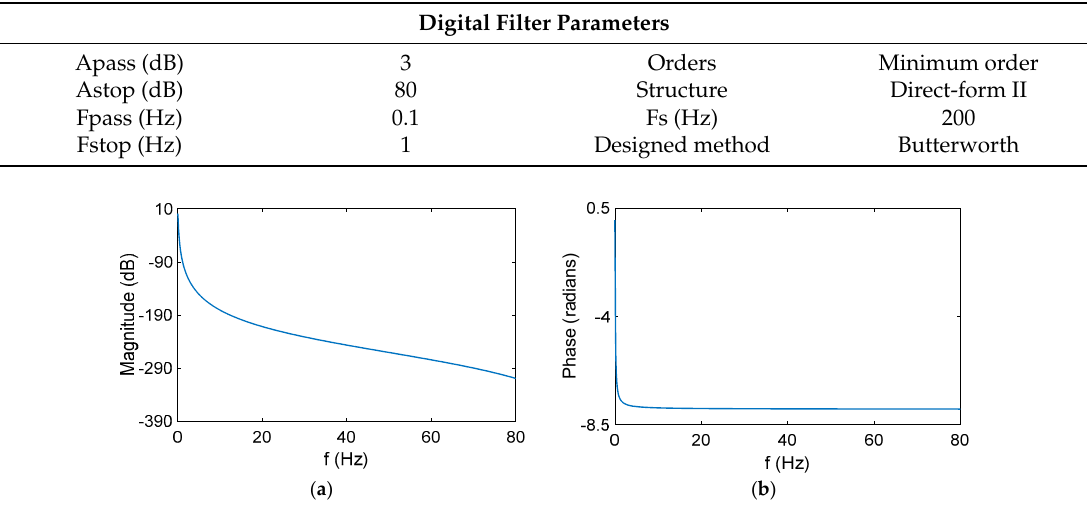
Figure 3. ( a ) The curves of amplitude-frequency response; ( b ) curves of the phase-frequency response.